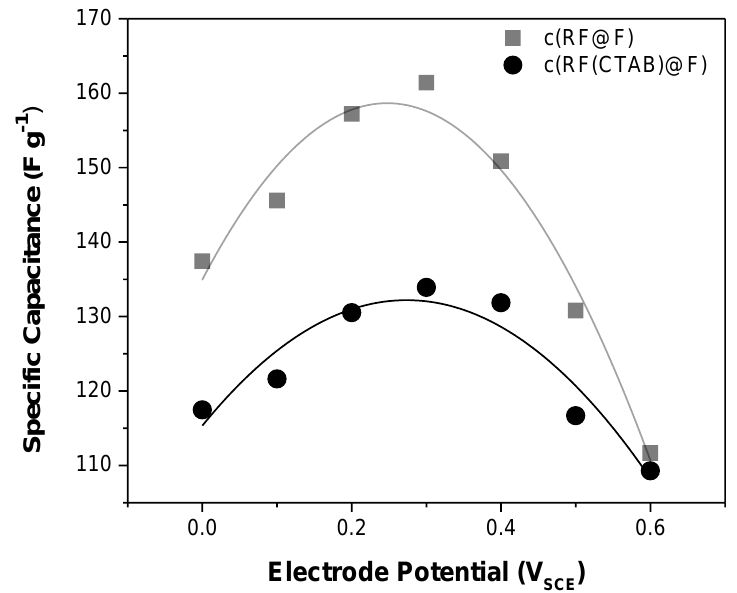
Figure 7. Specific capacitances of c(RF@F) (gray squares) and c(RF(CTAB)@F) (black circles) electrodes. The capacitances were measured from EIS at the low-frequency end (28 mHz) and different applied potentials in 1 M H 2 SO 4 solution.